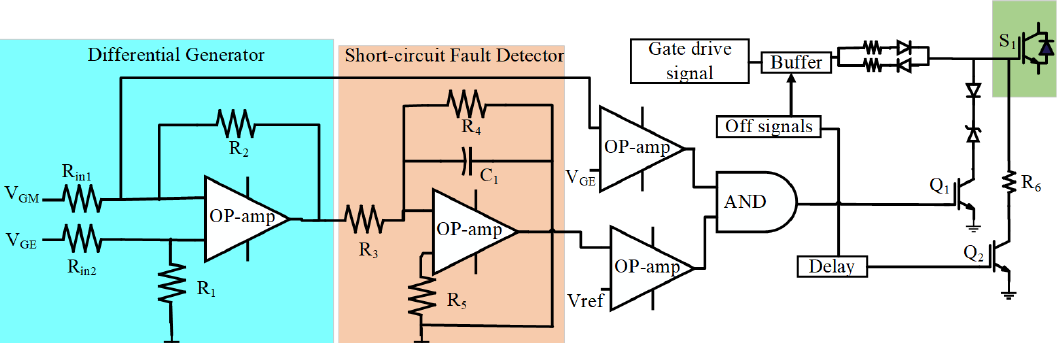
Figure 4. Short-circuit fault detection circuit.